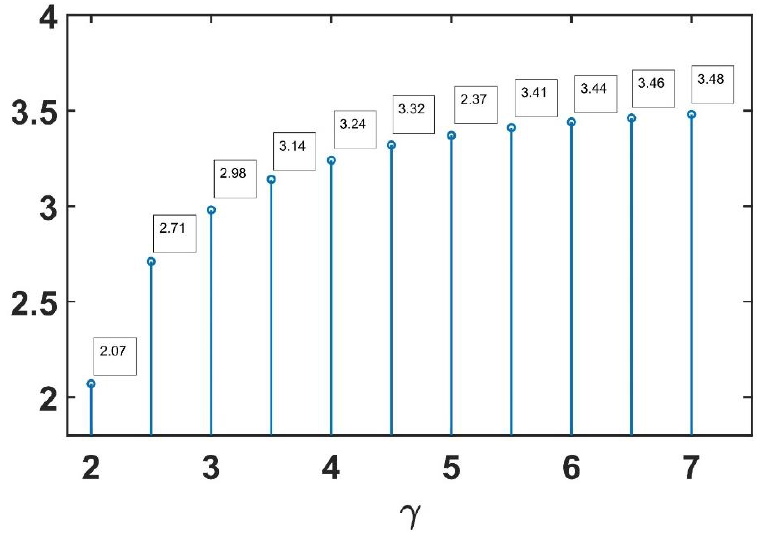
a for different  . Figure 1. Maximum a 3 for different γ 3